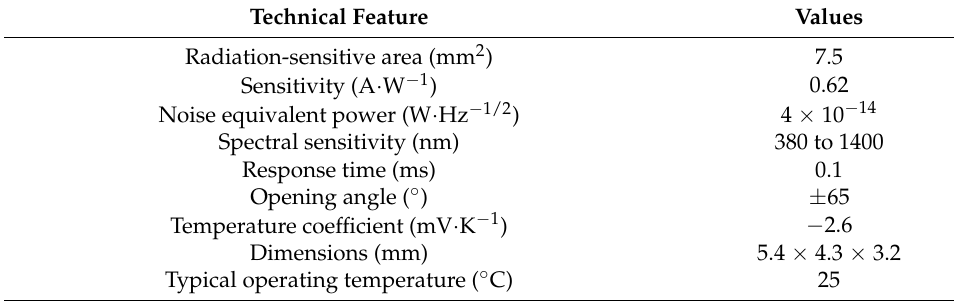
Table 1. Basic features of bwp34 photodiode [24].